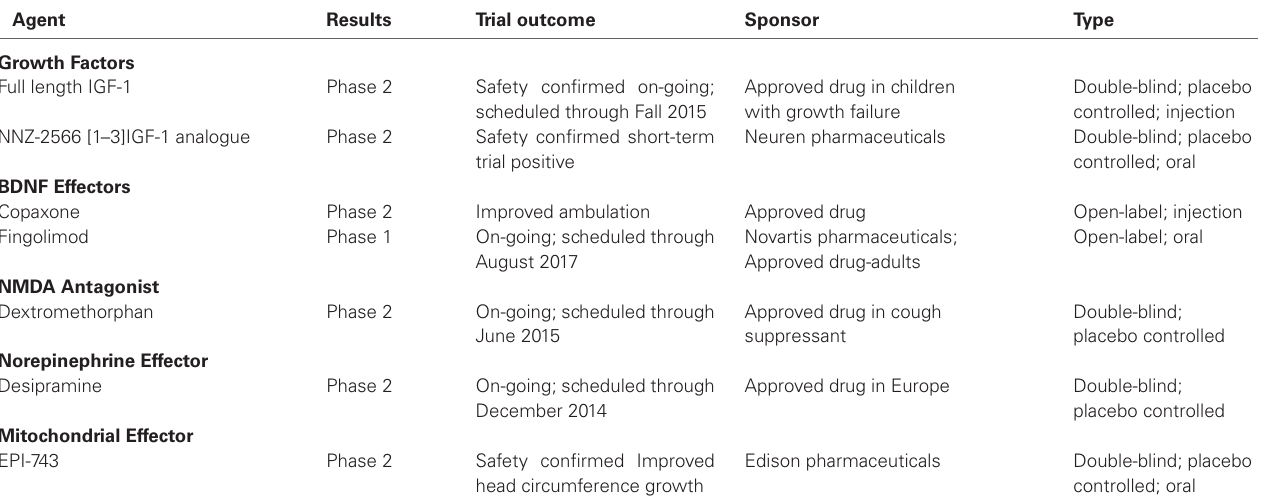
Table 4 | Current clinical trials in RTT individuals